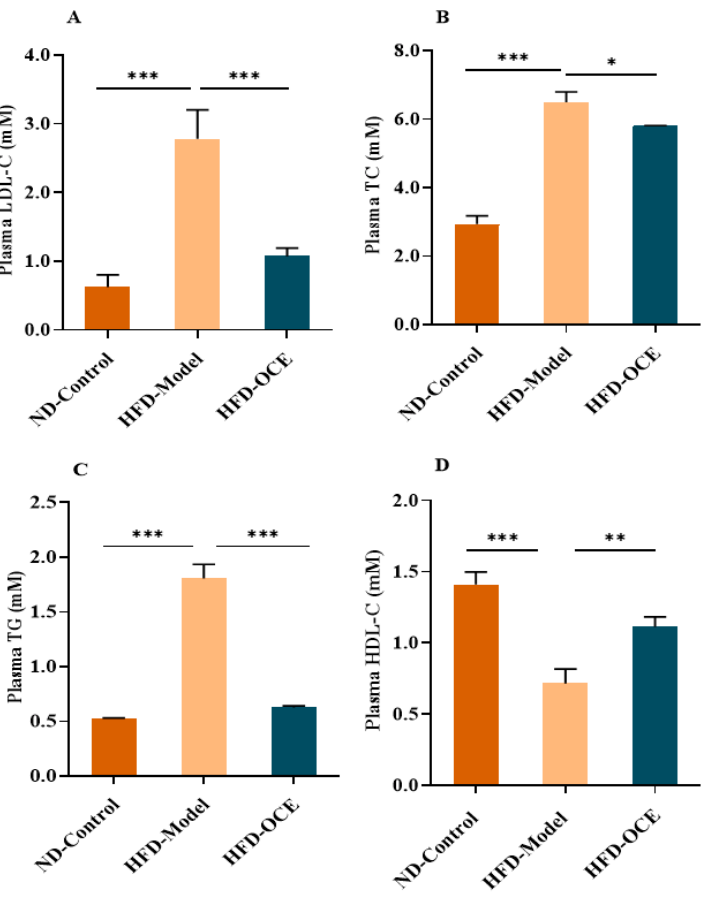
Figure 2. Effects of OCE on the serum lipid levels in mice. ( A ) LDL-C concentration (mM, n = 4). ( B ) TC concentration (mM, n = 4). ( C ) TG concentration (mM, n = 4). ( D ) HDL-C concentration (mM, n = 4). Mice were fed with normal diet (ND) or high-fat diet (HFD) with or without OCE at the dose of 10 mg/kg by gavage once a day for 12 weeks. Values were the mean ± standard deviation (SD), * p < 0.05, ** p < 0.01, *** p < 0.001 (one-way